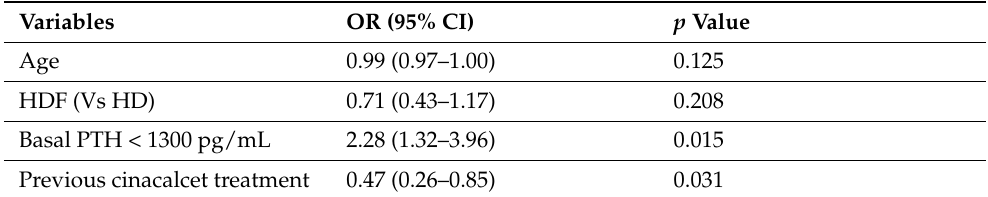
Multivariate regression with stepwise model to achievement of PTH reduction endpoint ≥ 30% at 6 months. OR, odds ratio; CI, confidence